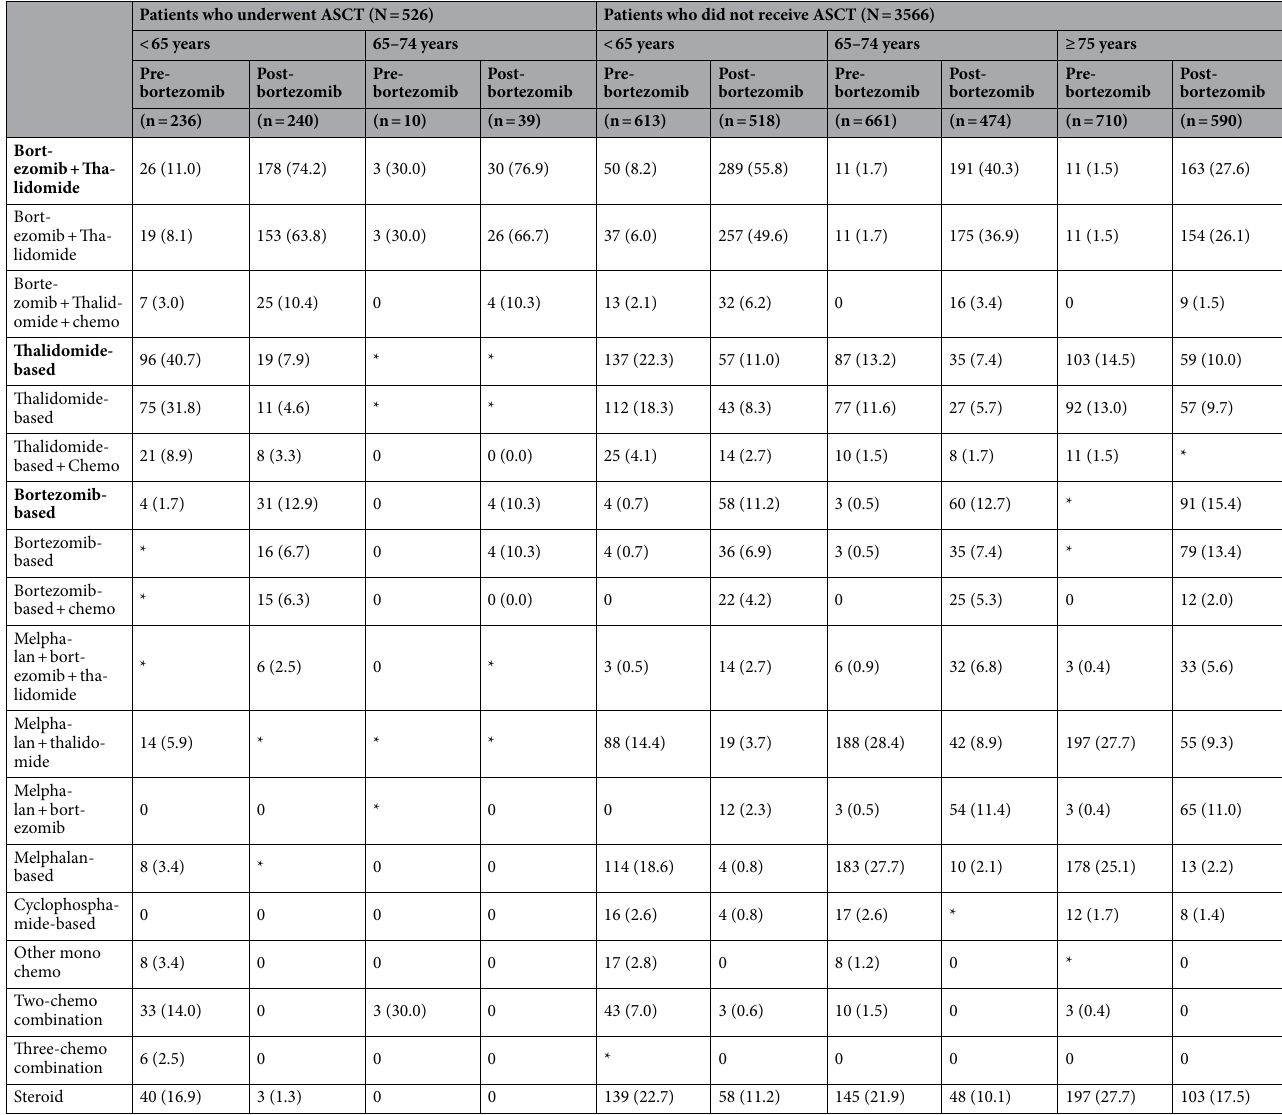
Table 2. First-line treatment regimens in MM patients overall and according to transplantation status by age category. ASCT autologous stem cell transplant. *To protect patient privacy, all non-zero counts that were less than three were